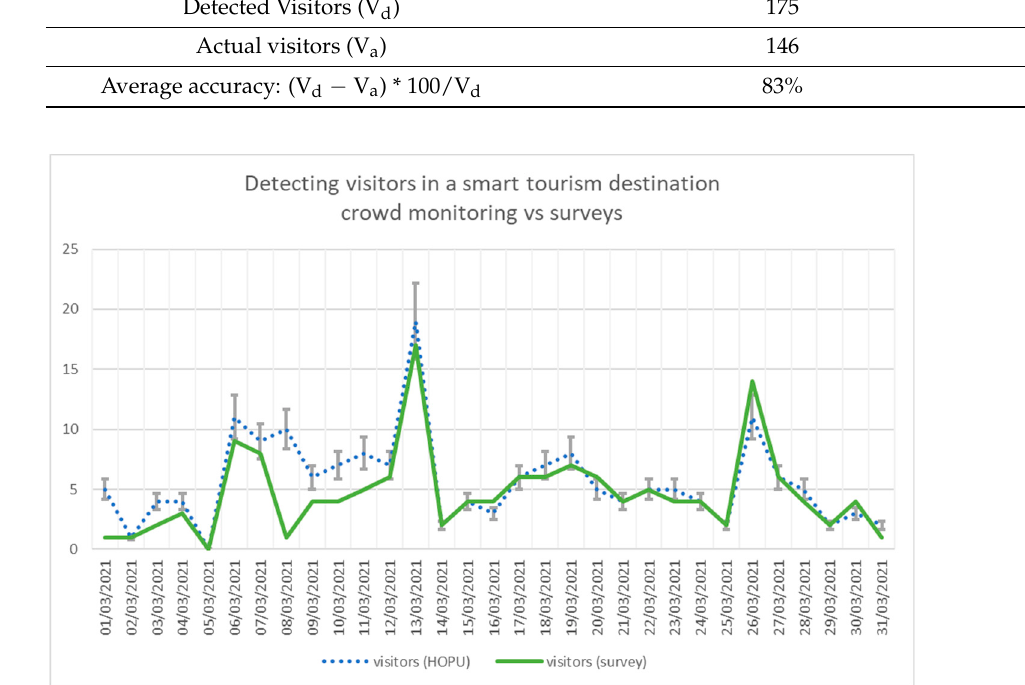
Figure 7. Using HOPU Smart Spot vs. manually conducted surveys to determine number of visitors in Alcoi.